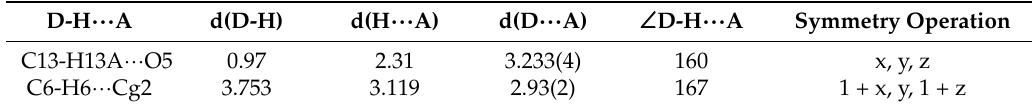
Figure 9. Intramolecular hydrogen bonds in complex 2 (hydrogen atoms, except those forming hydrogen bonds, are omitted for clarity). Table 6. The main hydrogen bonds [Å,°] for complex 2 .